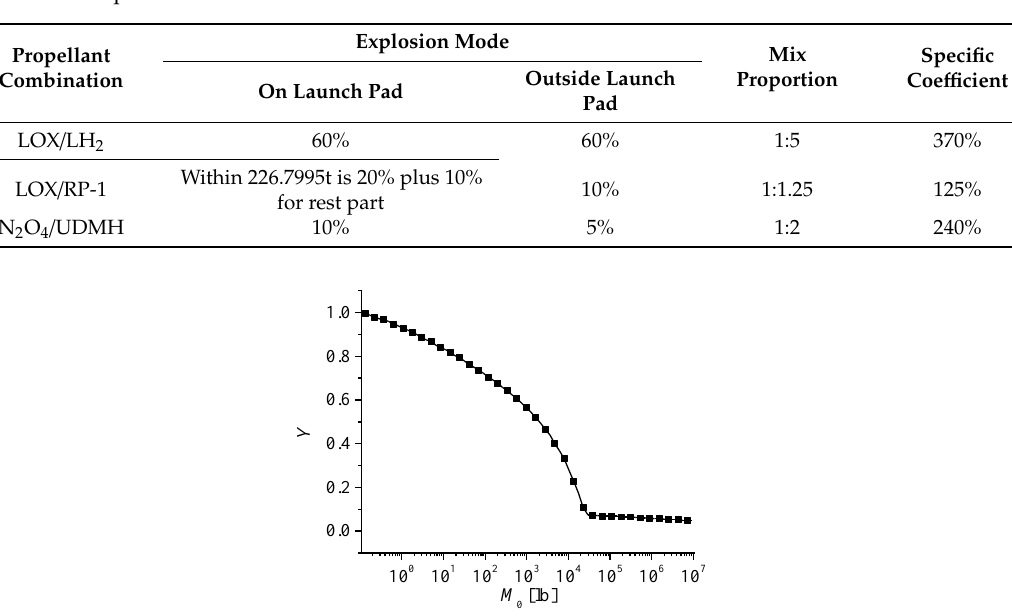
Table 1. Equivalent yields at different stages of a certain rocket.